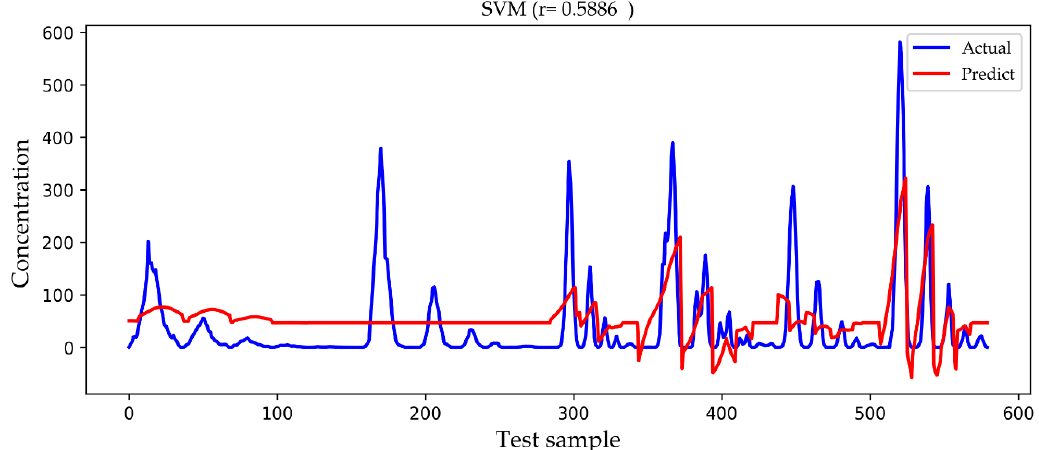
Figure 10. A comparison of the actual and predicted values of the SVM model. Actual drawn in blue represents the true concentration value, and Predict drawn in red represents the predicted result.